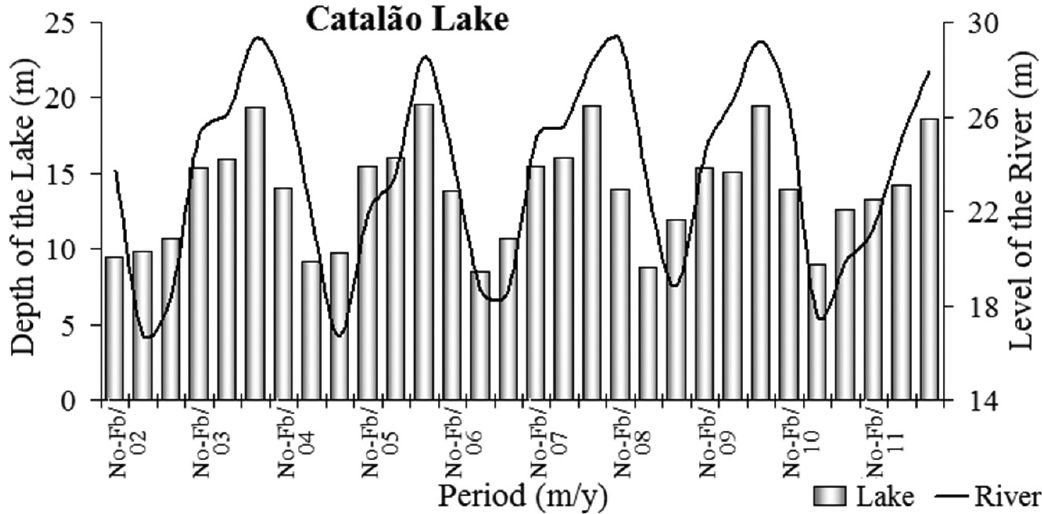
Figure 2. Lake depth and Solimões River hydrological level during the period of November 2001 to October